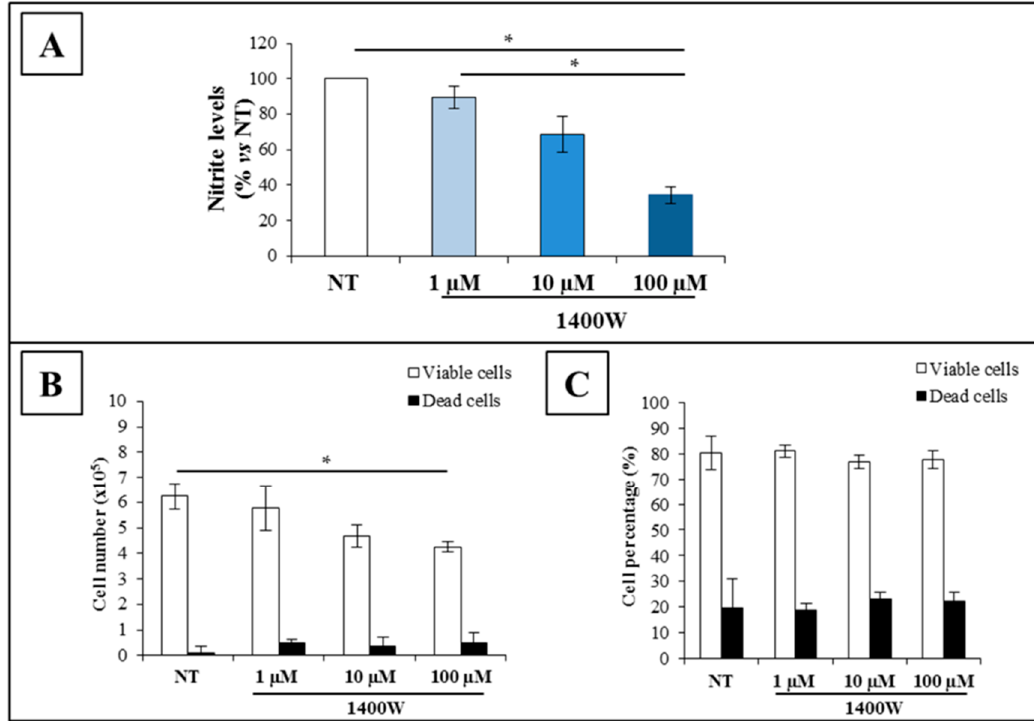
Figure 1. Effect of different concentrations of 1400W, a nitric oxide synthase 2 (NOS2) inhibitor, on U-87 MG human glioblastoma (GBM) cell line. ( A ) Nitrite levels in media from adherent U-87 MG cells cultured for 24 h without (not treated, NT) or with NOS2 inhibitor, 1400W (1 µ M,10 µ M, and 100 µ M). The results presented as percentage vs. NT are expressed as the mean ± SEM from two independent experiments in triplicate. ( B ) U-87 MG cells were treated with 1400W at 1 µ M, 10 µ M,100 µ M, or PBS (NT) for 24 h, and the number of viable and dead cells was assessed by Trypan blue exclusion test and ( C ) by propidium iodide (PI) staining. Results are presented as the mean ± SEM of two independent experiments in triplicate. For comparative analysis of groups of data, one-way ANOVA followed by Bonferroni post hoc test was used (* p < 0.05).